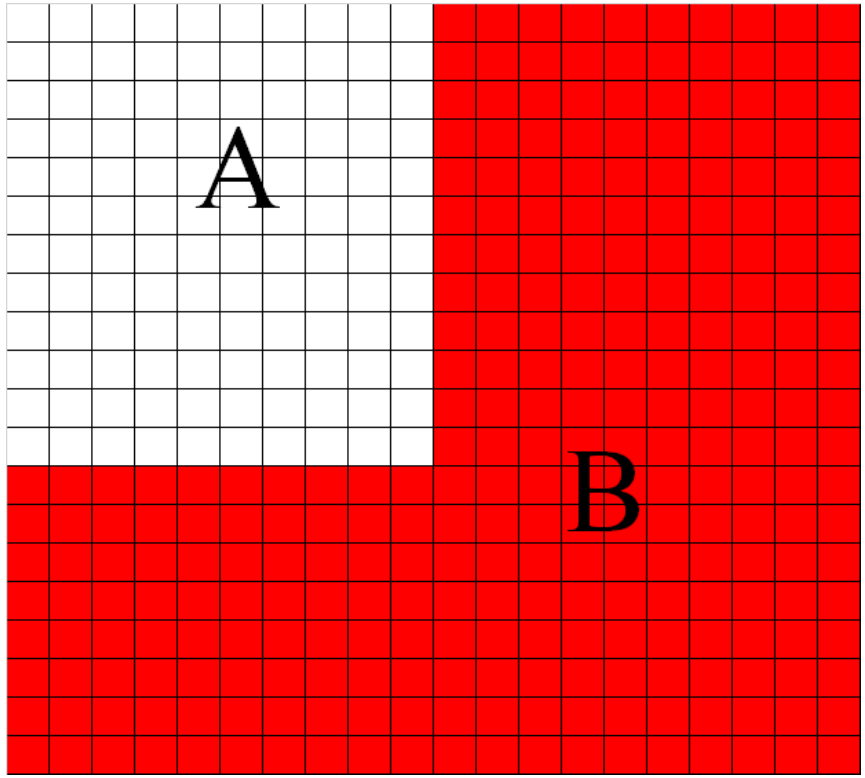
Figure 6. Schematic diagram of area